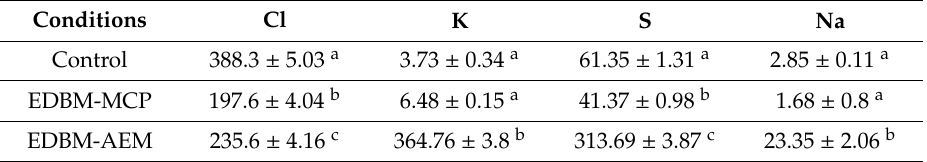
Table 3. Mineral concentration (mg / L) of hemoglobin solution at the end of the hydrolysis.